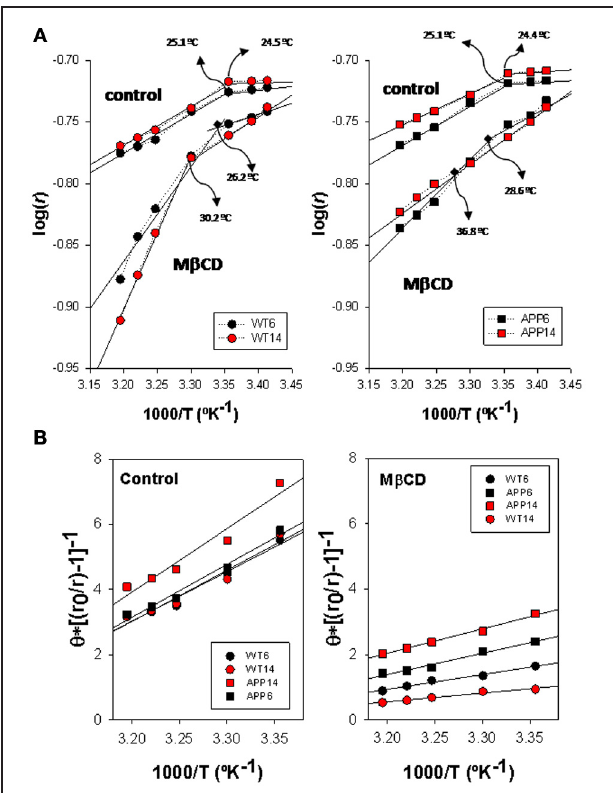
FIGURE 3 | Biophysical characterization of lipid rafts from AP/PS1 and WT brain cortex probed with TMA-DPH. (A) Arrhenius plots for steady-state anisotropy in WT (left) and APP/PS1 (right) animals. (B) Microviscosity analyses based on modified Perrin equation for steady-state fluorescence anisotropy for TMA-DPH under control (left panel) and after M β CD treatment (right panel) temperature. Discontinuity temperatures ( Td ) are